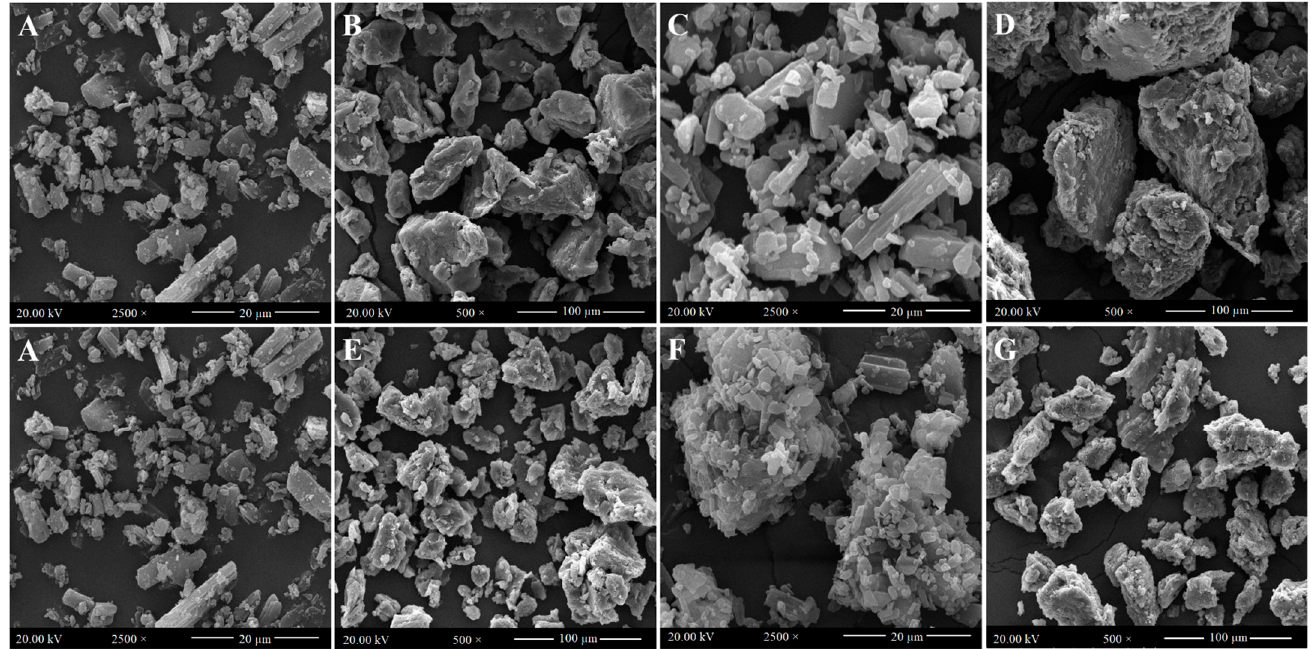
Figure 2. Scanning electron microscopic images of ( A ) Supplied FFH, ( B ) Supplied PEG 20,000, ( C ) Physical mixture of FFH with PEG 20,000 at 1:4 ratio (PM-FP20K (1:4) ), ( D ) Solid dispersion of FFH with PEG 20,000 at 1:4 ratio (SD-FP20K (1:4) ), ( E ) Supplied poloxamer 188, ( F ) Physical mixture of FFH with poloxamer 188 at 1:4 ratio (PM-FP188 (1:4) ), ( G ) Solid dispersion of FFH with poloxamer 188 at 1:4 ratio (SD-FP188 (1:4) ).